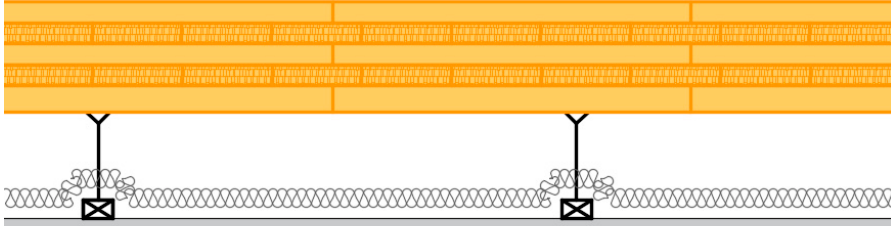
Figure 4. Configuration 2: Bare floor coupled with suspended ceiling.